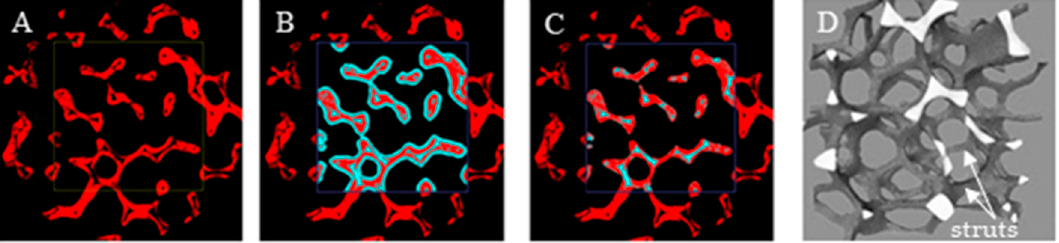
Figure 7. Region of interest (ROI) after ( A ) binarization, ( B ) dilatation operation, ( C ) erosion operation, ( D ) three-dimensional (3D) reconstruction.